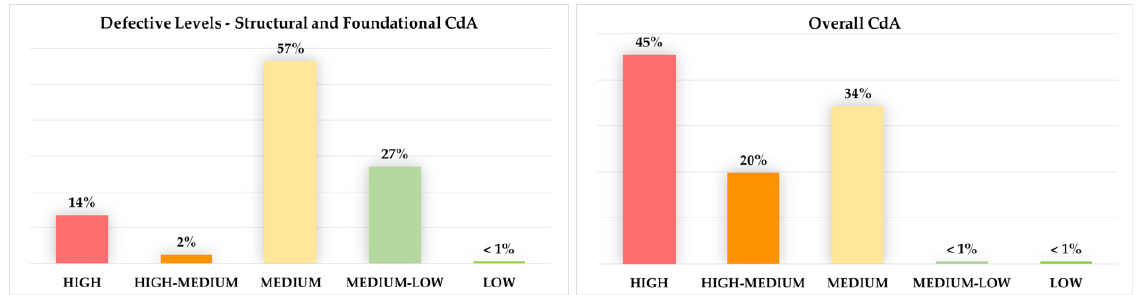
Figure 11. Structural and Foundational CdA and Overall CdA forecast by LG20 approach.